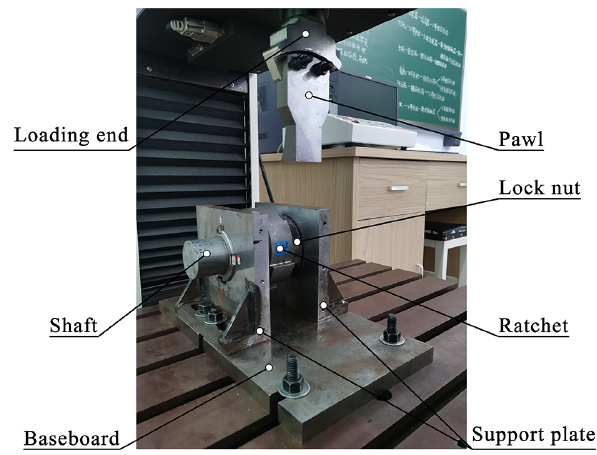
Figure 12. Structure of the ratchet test